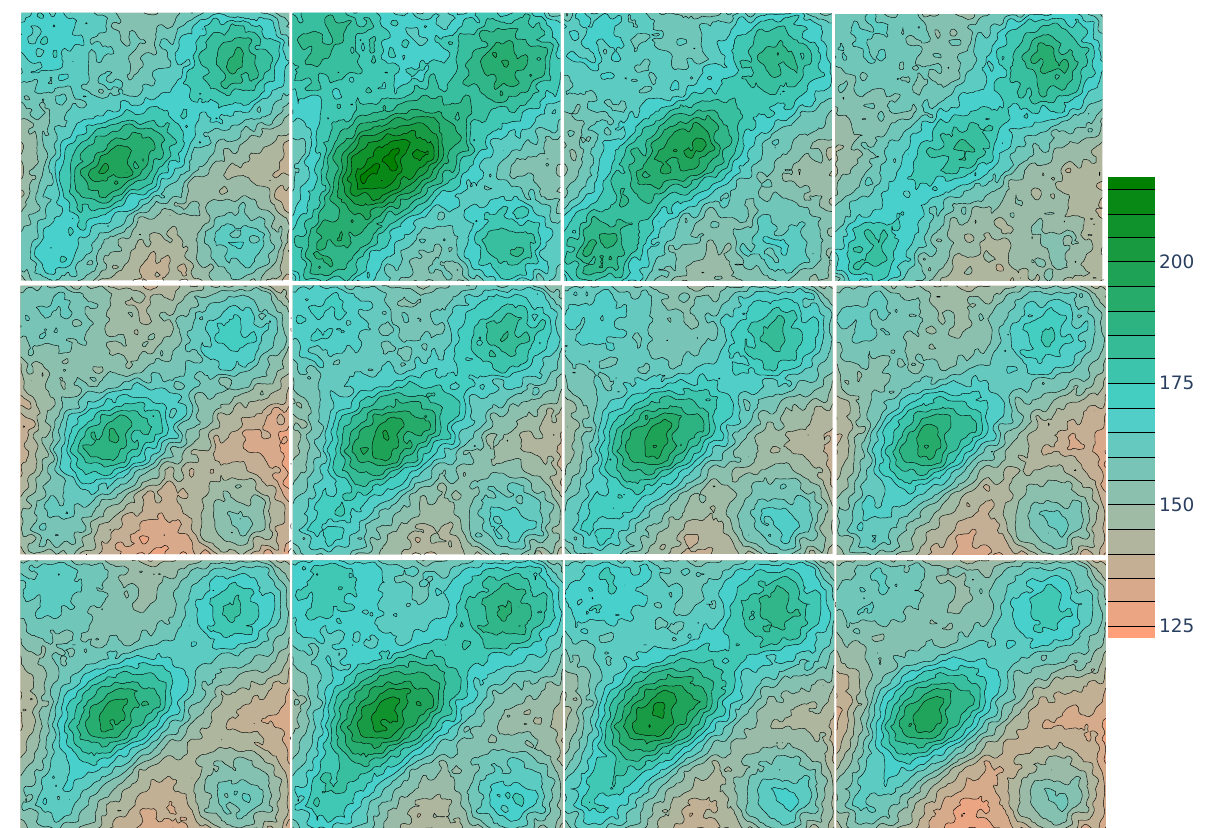
Figure 9. Prediction average height ( mm ) using approximate Bayesian inference for δ = { 32,64 } , s = 4 for a 10 m × 10 m pasture for L out = { 1,6, 11,15 } , respectively. Input sequence to the DeepPaSTL network L in = 15 is 01 April 2019 to 27 May 2019 and output prediction L out = 15 every 4 days. The predictions are 1,24,44,60 days in the future during the peak pasture growth time of 31 May 2019 to 26 July 2019. ( Top ) Target values acquired from point cloud measurements with LIDAR of 3D pasture generated in Gazebo. ( Middle ) δ = 64 generally underestimates the growth of the pasture resulting in larger errors; however, it generally has a better tracking for lower lying areas or receding pasture heights especially for the longer horizon. ( Bottom ) δ = 32 The lower quantization tracks the peaks and troughs of the sward height measurements quite accurately for the near